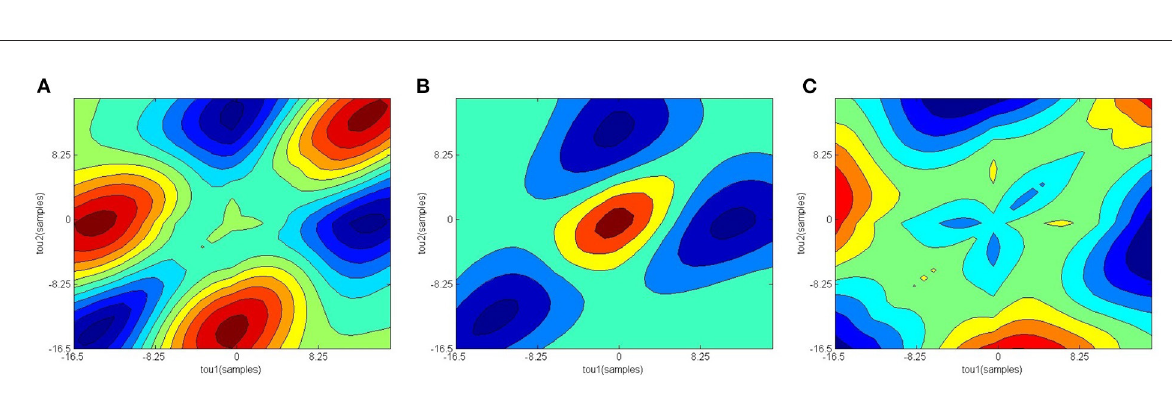
FIGURE4 Cumulant plots, (A) normal, (B) MDDSI − , (C) MDDSI+ ECG